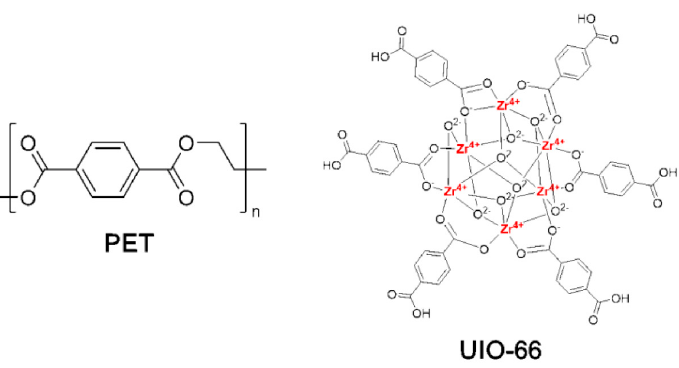
Figure 1. Structure of PET and UIO-66(Zr). All the chemicals were directly employed without being further